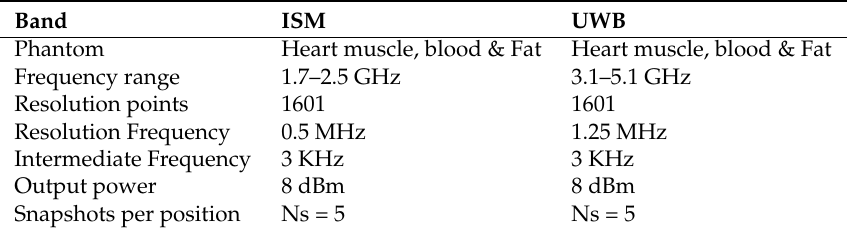
Figure 2. Measurement Setup. Table 1. Setup